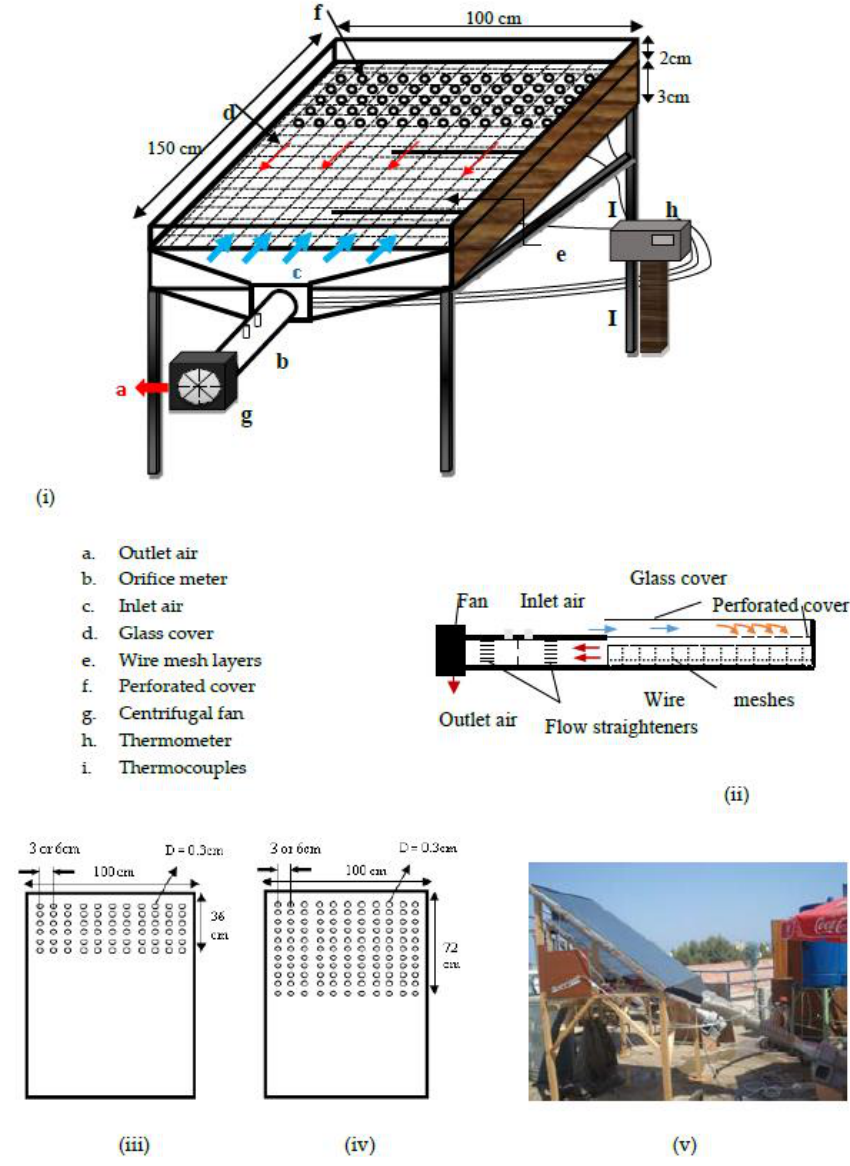
Figure 1. ( i ) Schematic view of the novel solar air heater, ( ii ) side view of the collector, ( iii ) one-fourth pierced Plexiglas cover, ( iv ) one-half pierced Plexiglas cover, ( v ) pictorial view of the experimental setup.